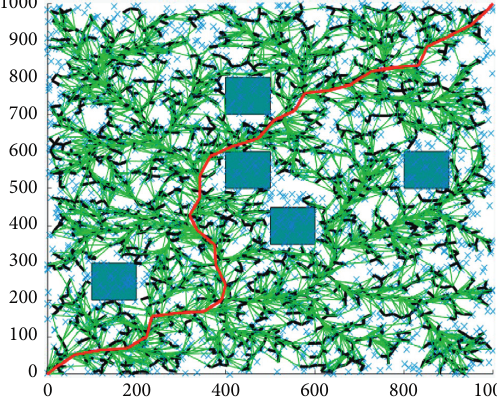
Figure 9: The path planned by PQ-RRT ∗ .